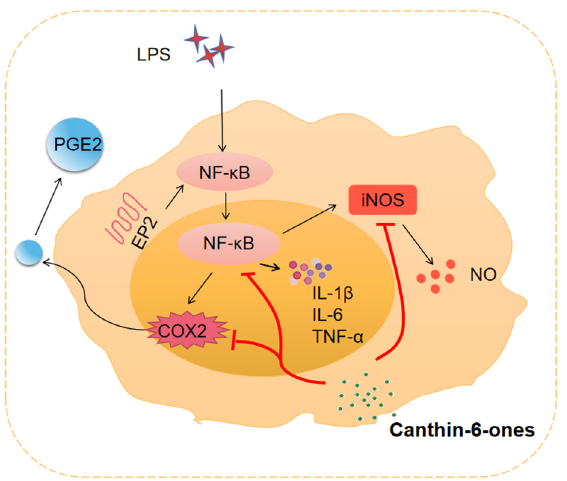
Figure 3. Target molecules of canthin-6-ones. Canthin-6-ones inhibit the production of pro-inflammatory cytokines, such as IL-1 β , IL-6, and TNF- α , whose production can be induced by a wide variety of intracellular or extracellular stimuli, such as pathogen-derived LPS. Moreover, studies have shown that canthin-6-ones can suppress the production of NO and its regulator, iNOS. In addition, the production of PGE2 and its regulator, COX2, can be suppressed by canthin-6-ones. Activation of NF- κ B mediates the production of NO, iNOS, COX2, and PGE2, which recruit many inflammatory cells, such as macrophages, to the in fl ammatory sites and promote chronic in fl ammation.